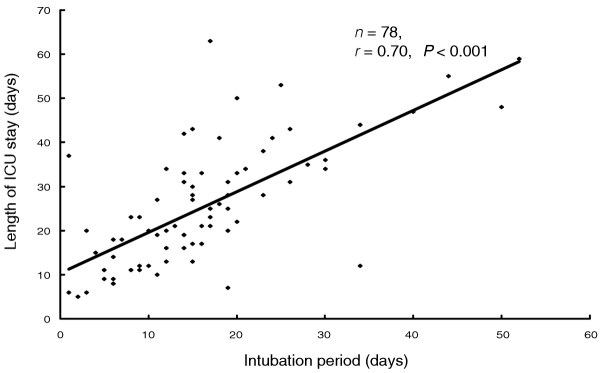
Correlation of intubation period and the length of intensive care unit (ICU) stay in patients who weaned successfully.